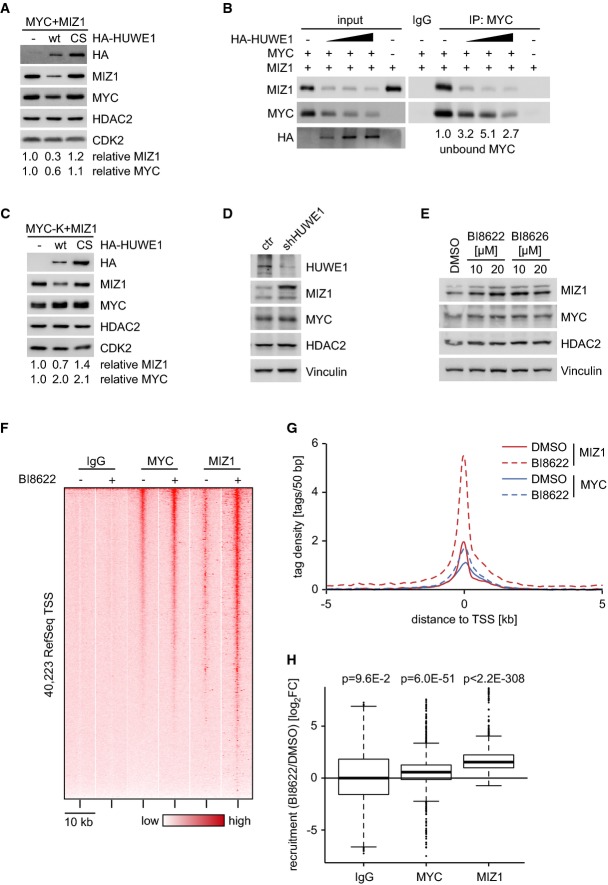
Effect of HUWE1 on MYC and MIZ1 complexesImmunoblot documenting levels of MYC and MIZ1 upon HUWE1 overexpression. HeLa cells were
transfected with plasmids expressing MYC, MIZ1, and HUWE1 (wt or catalytically inactive CS mutant).
Relative protein levels of MIZ1 and MYC are shown below the immunoblot
(n = 3).Interaction of MYC and MIZ1 upon ectopic expression of HUWE1. HeLa cells were transfected with
the indicated expression vectors. Cell lysates were immunoprecipitated with MYC antibody or IgG as
control, and immunoblots of the eluates were probed with indicated antibodies. As input control,
5% of the lysate was loaded. For each immunoprecipitate, the relative amount of MYC that is
not bound to MIZ1 is shown below the blot (n = 2).Steady-state protein levels of lysine-free (MYC-K) MYC and MIZ1 upon HUWE1 overexpression. The
experiment was performed as described in (A).Immunoblots documenting steady-state protein levels of MYC and MIZ1 upon HUWE1 depletion in
Ls174T cells.Steady-state protein levels of MYC and MIZ1 upon HUWE1 inhibition. Ls174T cells were treated with
the indicated concentrations of HUWE1 inhibitors or DMSO as control. After 24 h, cells were
lysed and immunoblots of the lysates probed with indicated antibodies.Heat map of all human transcription start sites (TSS) (±5 kb) documenting increased
MIZ1 binding upon treatment with BI8622 (20 μM) in Ls174T cells. Genes were ranked
according to MYC occupancy in DMSO control situation.Tag density distribution of MYC and MIZ1 around human TSS before and after treatment with BI8622.
Cells were treated as described in (A). Tags were counted in 50 bp windows, and tags of the
respective IgG control were subtracted.Boxplot illustrating recruitment (as log2FC) of MYC and MIZ1 after BI8622 treatment at
MIZ1-bound promoters (−1 kb to +0.5 kb) containing a consensus E-box
(CACGTG; n = 1711). Cells were treated as described in (A).
For analysis, tags were counted in a region ±100 bp around the summit of the MIZ1 peak
and P-values were calculated using a two-tailed, one-sample t-test
with μ = 0.